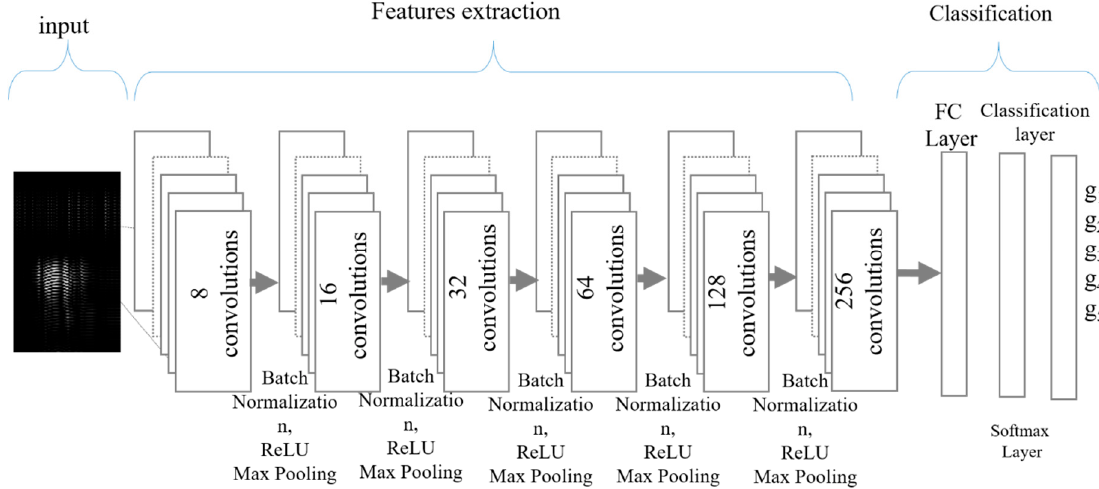
Figure 8. Architecture of implemented Convolutional Neural Network with 6 hidden layers.